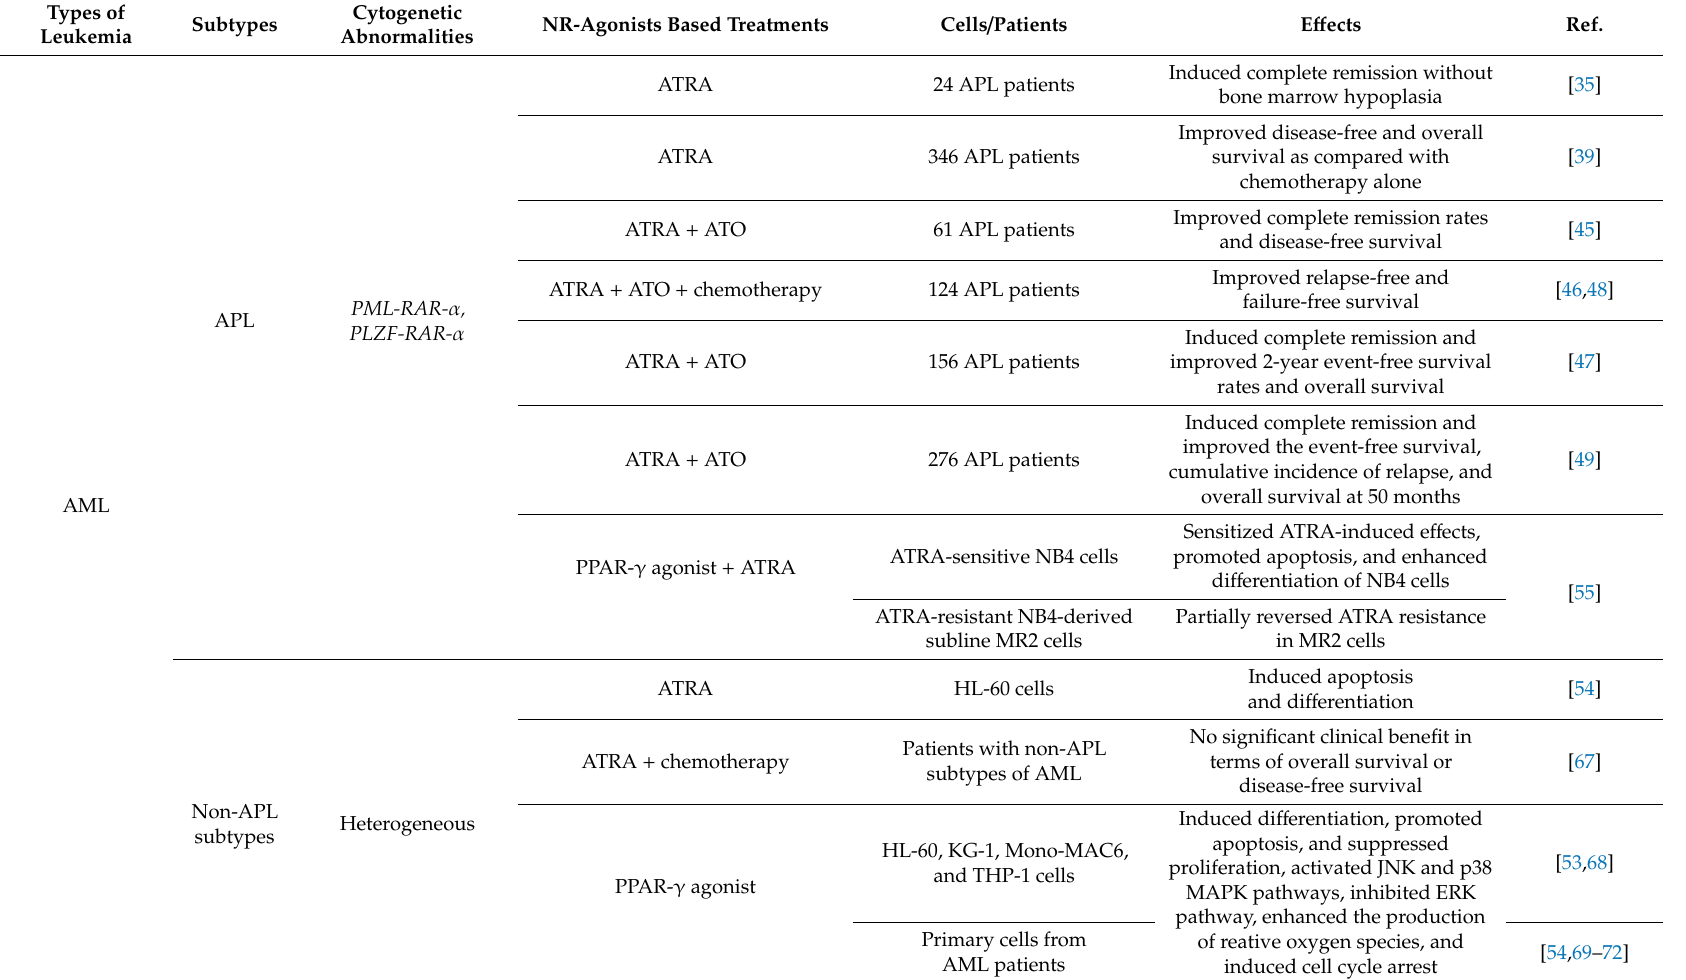
Table 1. Examples of studies on selected NR agonists-based treatments in AML and